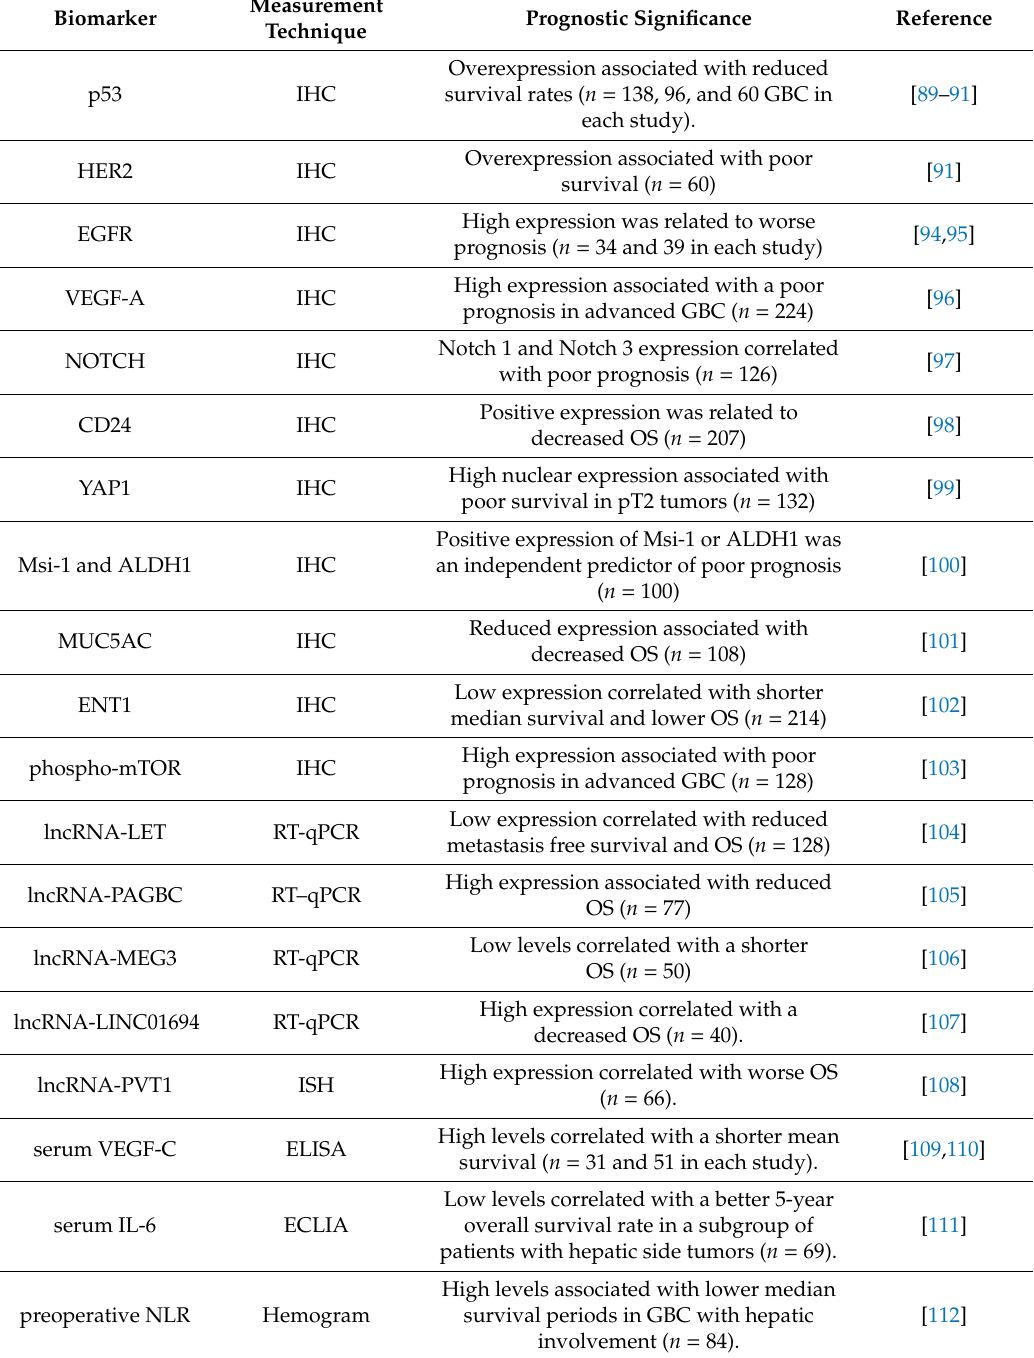
Table 3. Candidate molecular biomarkers for predicting prognosis in gallbladder